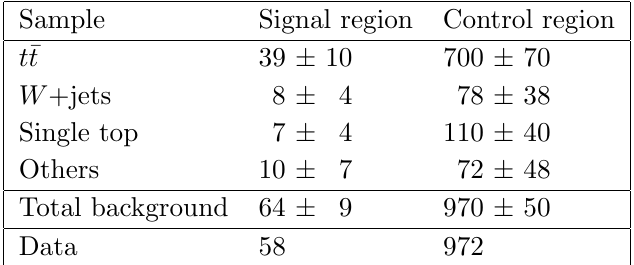
Table 2 . Event yields in the signal and control regions after the background-only (cid:12)t to the signal and control regions. The uncertainties include statistical and systematic uncertainties. The uncer- tainties in the individual background components can be larger than the uncertainty in the sum of the backgrounds, which is strongly constrained by the data.